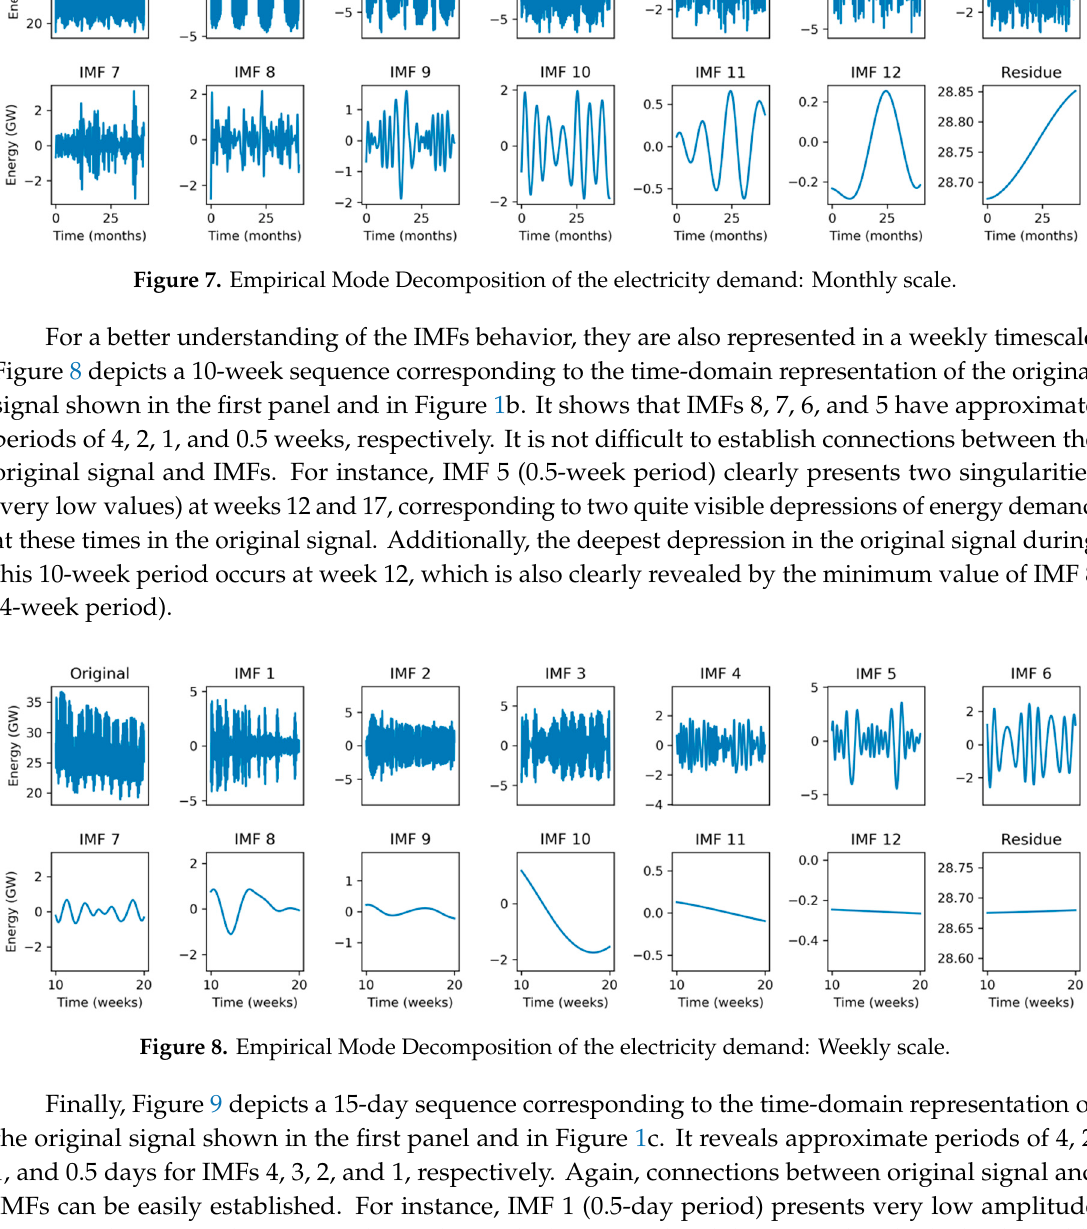
Figure 9. Empirical Mode Decomposition of the electricity demand: Daily scale. After the EMD process, every resulting IMF does satisfy the conditions expressed in Section 2.4 for having a meaningful Hilbert Transform (HT). The electricity demand Hilbert–Huang Transform (HHT) is then no more than the ensemble of the HT of each IMF, as reflected in Equation (17), which is depicted in Figure 10a. The plot represents, for each IMF, the instantaneous frequency (vertical axis) versus time (horizontal axis), while the instantaneous amplitude corresponding to each point is also color-coded. This plot can be seen as 13 overlapping Hilbert Spectra (corresponding to each of the 12 IMFs plus the residue). As the graph covers the full timescale, it is drawn as a scatter plot for a better interpretation. On the other hand, Figure 10b shows Marginal Hilbert–Huang Spectrum as it is defined in Equation (19). The accumulated-over-time amplitude (vertical axis) versus instantaneous frequency (horizontal axis) is plotted, with all the IMFs added.